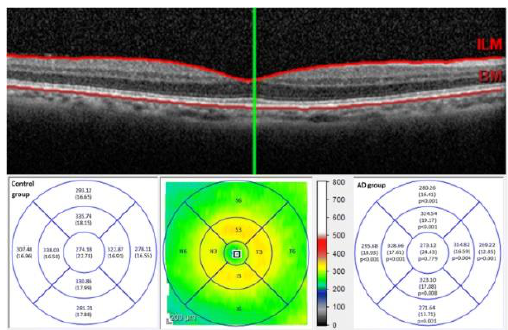
Figure 2. OCT image of the human retina and comparison of macular thickness in a person without Alzheimer’s disease (AD), and patient with AD (taken with the permission of [14]).